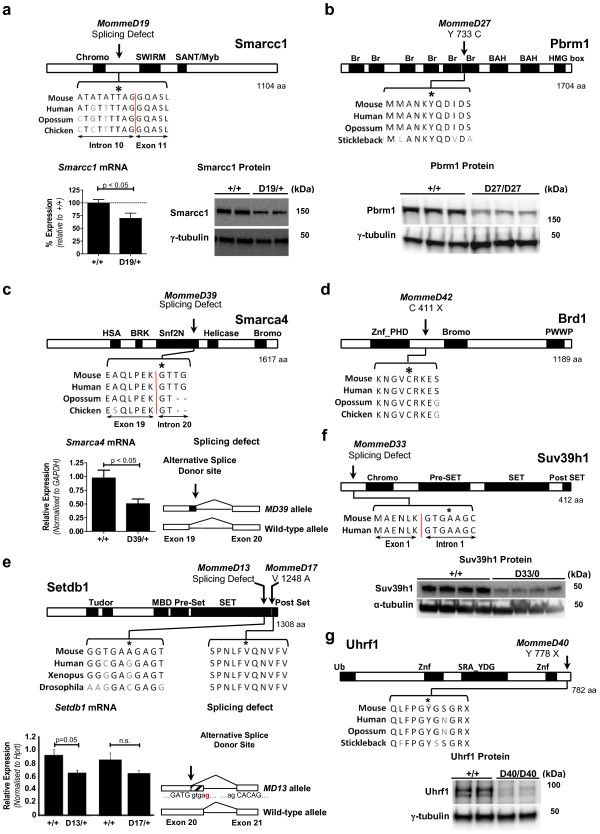
Causative mutations in MommeD19, MommeD27, MommeD39, MommeD42, MommeD13, MommeD33 and MommeD40. (a)MommeD19 carries a mutation at a splice site of Smarcc1. Real-time RT-PCR and immunoblotting of embryos at 12.5 days post-coitum (dpc) showed reduced levels of Smarcc1 mRNA and Smarcc1 protein in heterozygotes (n ≥ 5 mice). Each track represents a different animal. Smarcc1 protein was detected at approximately 160 kDa. (b)MommeD27 harbors a mutation in a bromodomain of Pbrm1. Western blot analysis of 14.5 dpc embryo heads showed reduced levels of Pbrm1 in homozygotes. Each track represents a different animal. Pbrm1 was detected at approximately 190 kDa. (c)MommeD39 carries a mutation at a splice site of Smarca4. Real-time RT-PCR showed reduced Smarca4 mRNA in testes of heterozygotes (n ≥ 4 mice). cDNA sequencing revealed that the mutation in Smarca4MommeD39 results in use of an alternative splice donor site. (d) The mutation in MommeD42 introduces a premature stop codon at amino acid 411 of the Brd1 protein. (e) Mutations in MommeD13 and MommeD17 occur in the conserved SET domain of Setdb1. Real-time RT-PCR of Setdb1 mRNA from testes of heterozygotes and age-matched wild types (n = 4 mice). cDNA analysis revealed that the Setdb1MommeD13 allele is associated with the use of an alternative splice donor site in exon 20, leading to a 62 bp truncation. (f)MommeD33 carries a mutation at a splice site in Suv39h1. Western blot analysis of Suv39h1 in adult thymus showed reduced Suv39h1 in hemizygous mutant males. Each track represents a different animal. Suv39h1 protein was detected at 48 kDa. (g) The mutation in MommeD40 introduces a premature stop codon at amino acid 778 of Uhrf1. Western blot analysis of Uhrf1 revealed greatly reduced levels in 9.5 dpc embryos homozygous for the Uhrf1MommeD40 mutation. Each track represents a different animal. Uhrf1 protein was detected at approximately 90 kDa. Error bars indicate ± standard error of the mean. N.s., not significant. Asterisks indicate mutation.